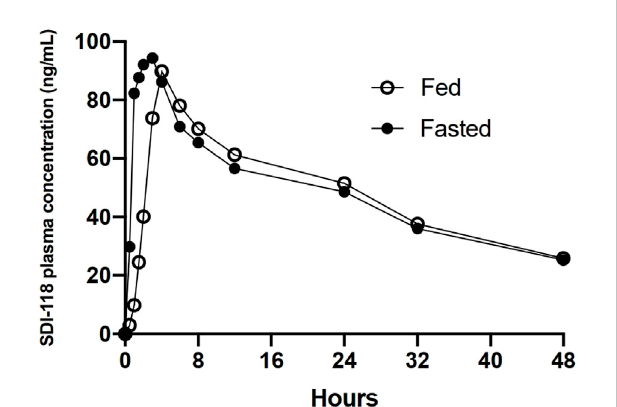
FIGURE 2 Graphic representation of the plasma concentration over time pro fi le of 10 mg of SDI-118 compared between the fasted and fed state. There was no signi fi cant difference in exposure based on C max and AUC. T max wasdelayedfrom1.5 honaverageinthefasted state to4 hon average after a standardized high fat